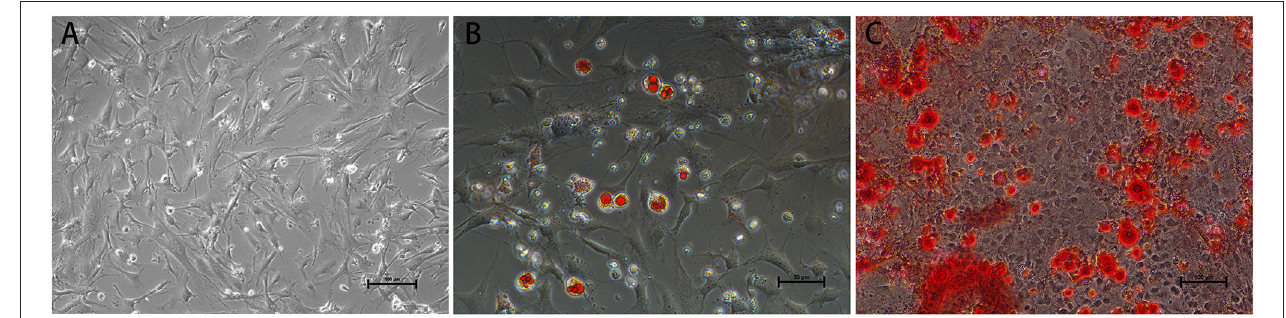
FIGURE 1 | Morphology and differentiation induction of MSCs. (A) Typical fibroblast-like cell morphology of MSCs in culture. Scale bar = 100 µ m. (B) Oil red staining demonstrating fat drops in cell bodies following 2w adipogenic induction. Scale bar = 50 µ m. (C) Alizarin red staining demonstrating calcium deposition in cell matrix following 2w osteogenic induction. Scale bar = 100 µ m.